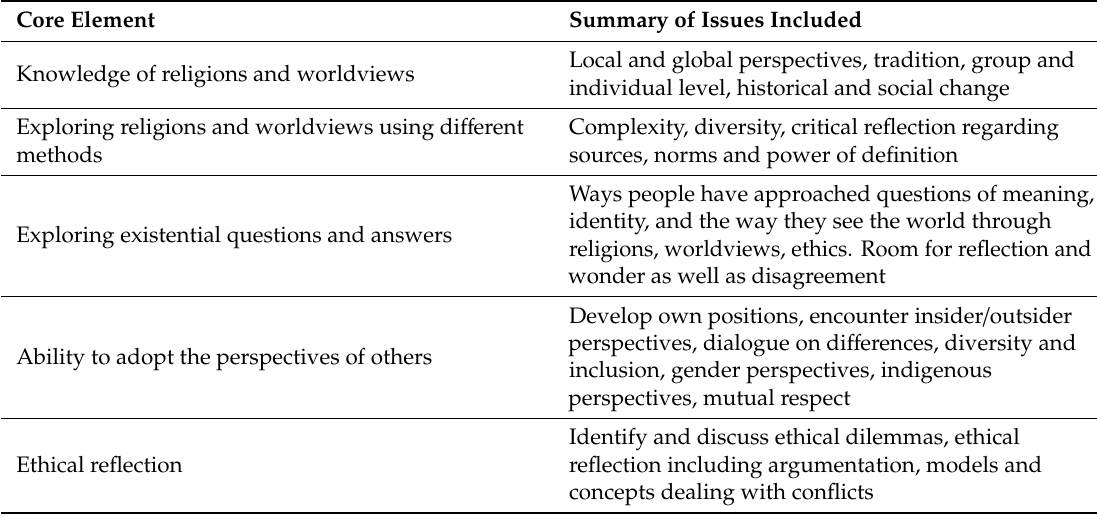
Table 1. Core elements in religion and world view